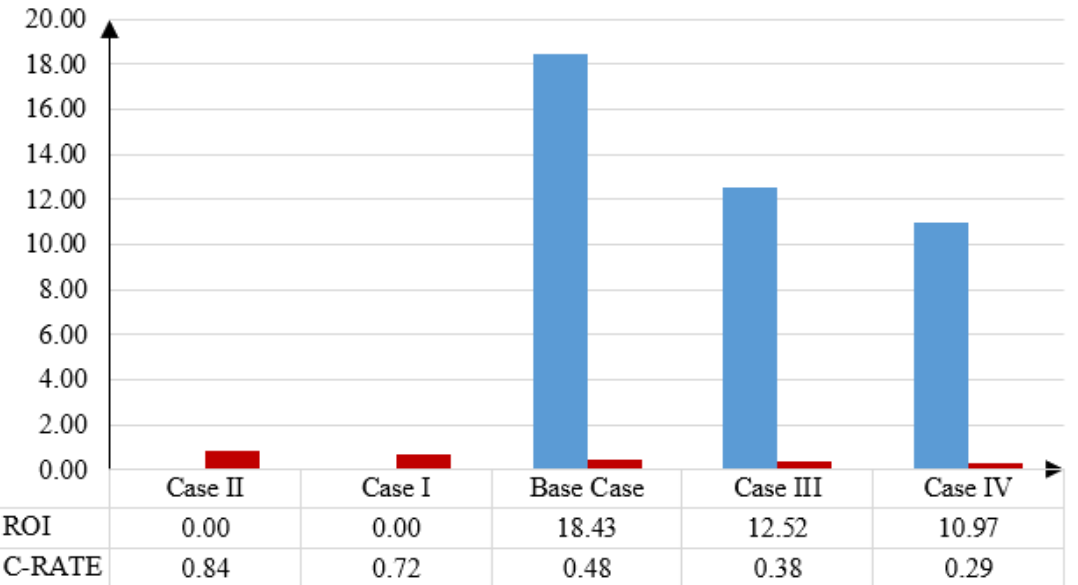
Figure 12. The results of C-rate sensitivity case study in terms of ROI (Return On Investment).